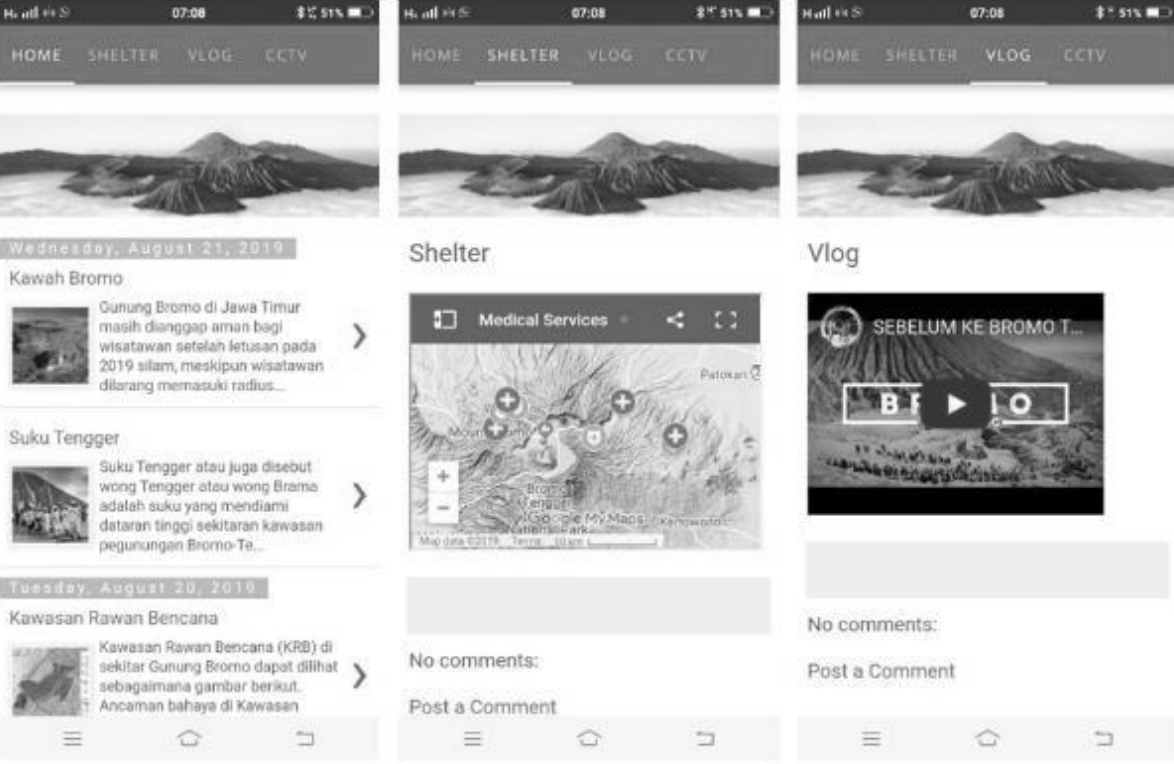
Figure 1. Application Interface with